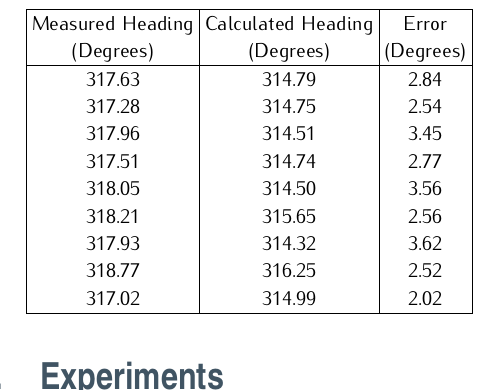
Table 3. Simple Path Measurements – Orientation